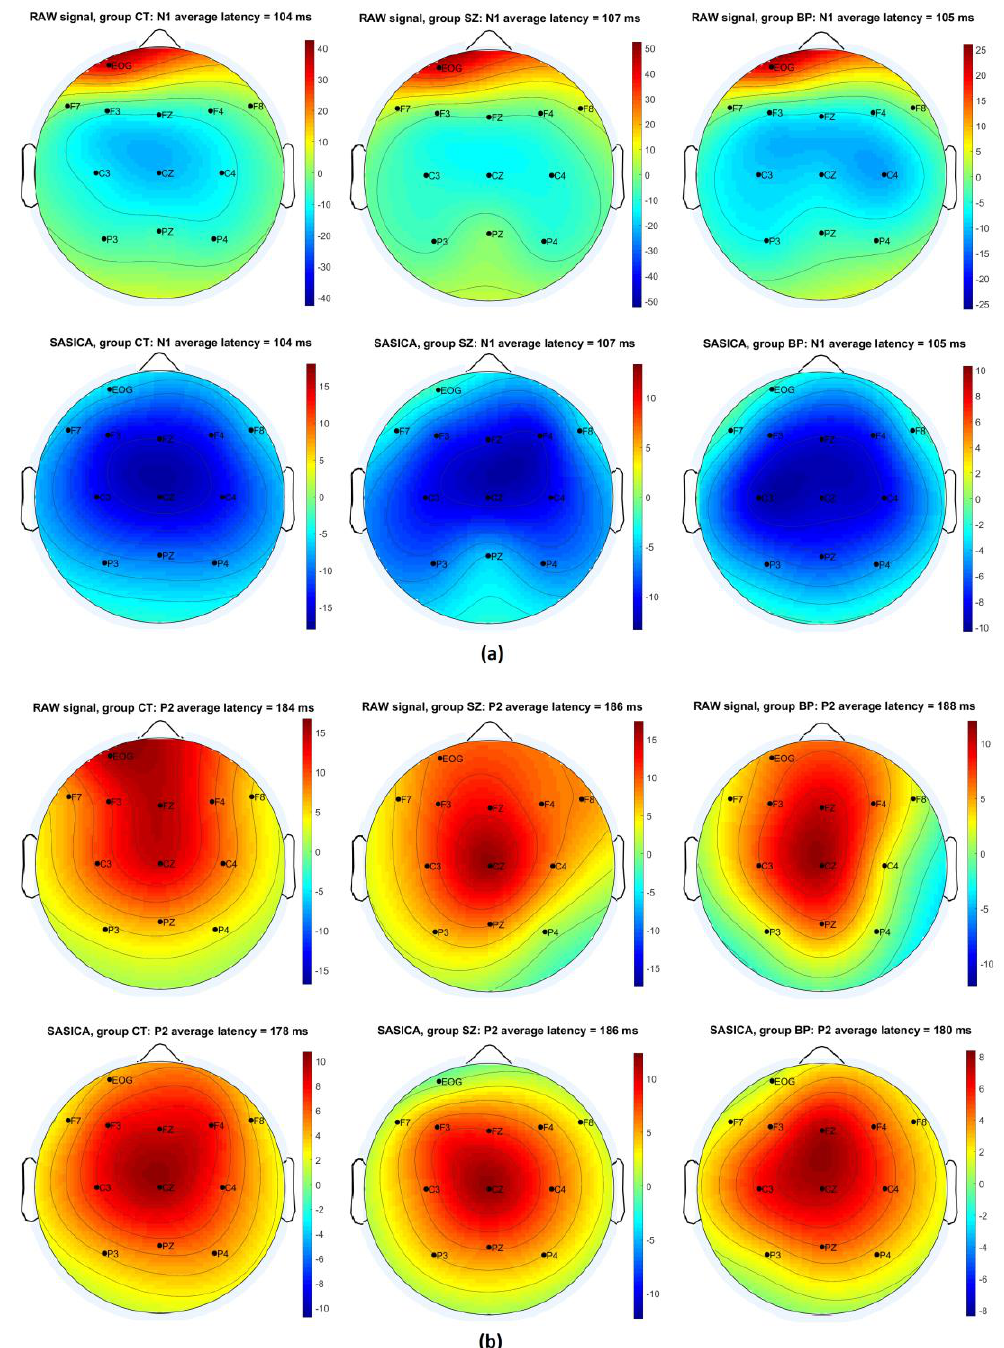
Figure 2. 2D topography (grand average ERPs) for the pulse alone (P) condition at latencies N1 ( a ) and P2 ( b ) from CT, SZ, and BP groups before (RAW signal) and after (SASICA) artifacts removal. 2D topography includes Frontal (F7, F3, Fz, F4, and F8), Central (C3, Cz, and C4) and Parietal (P3, Pz, and P4) channels. Eye-blink artifacts due to startle reflex affect mainly the N1 component (RAW signal). After the artifacts’ removal (SASICA), the N1 component displays normal negative activation (blue color) across all scalp